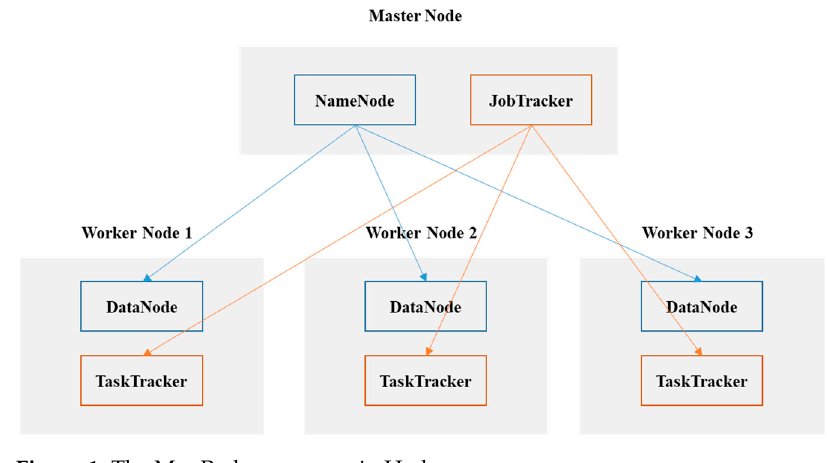
Figure 1. The MapReduce process in Hadoop.